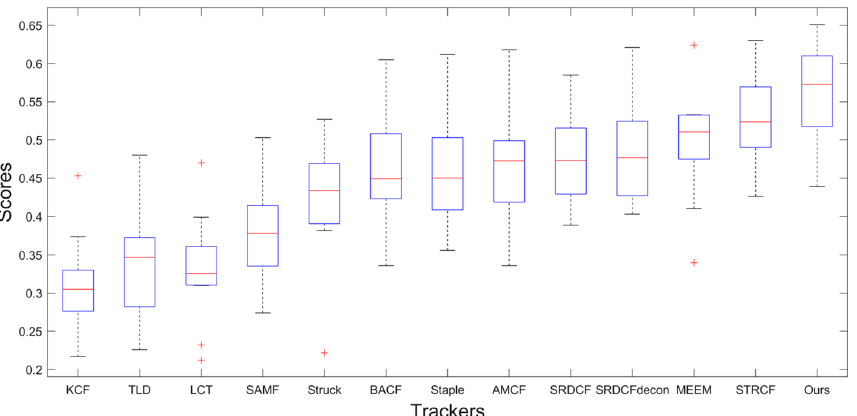
Fig. 8 Analysis of precision scores for all trackers with different